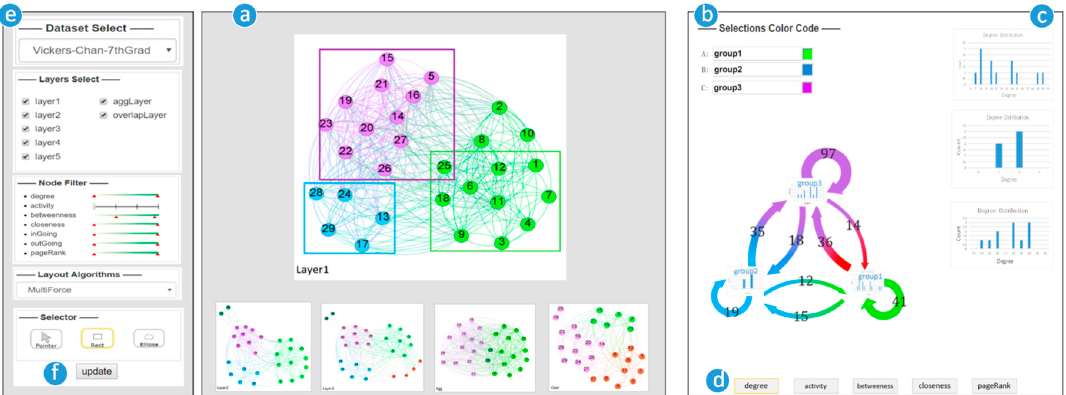
Figure 3. Graphical user interface of the implemented prototype showing all coherent components: ( a ) Topological structure view showing all the network layers in 2D panel as node-link diagrams. The layer1 is selected and positioned at the view’s center. ( b ) High-level informatic-style view showing the high-level patterns representations with Venn diagrams or directed arrows; the latter is shown here to present the interaction pattern between the three areas are selected in topological structure view. ( c ) Attributes charts views showing the statistical information of nodes in the selected area and which kind is to be shown is controlled by the ( d ) attribute selection component. ( e ) Interaction components showing the operations method to interact with users, respectively: The data inputting, layer selection, node filter, layout algorithms selection, and region selection. ( f ) Update button.